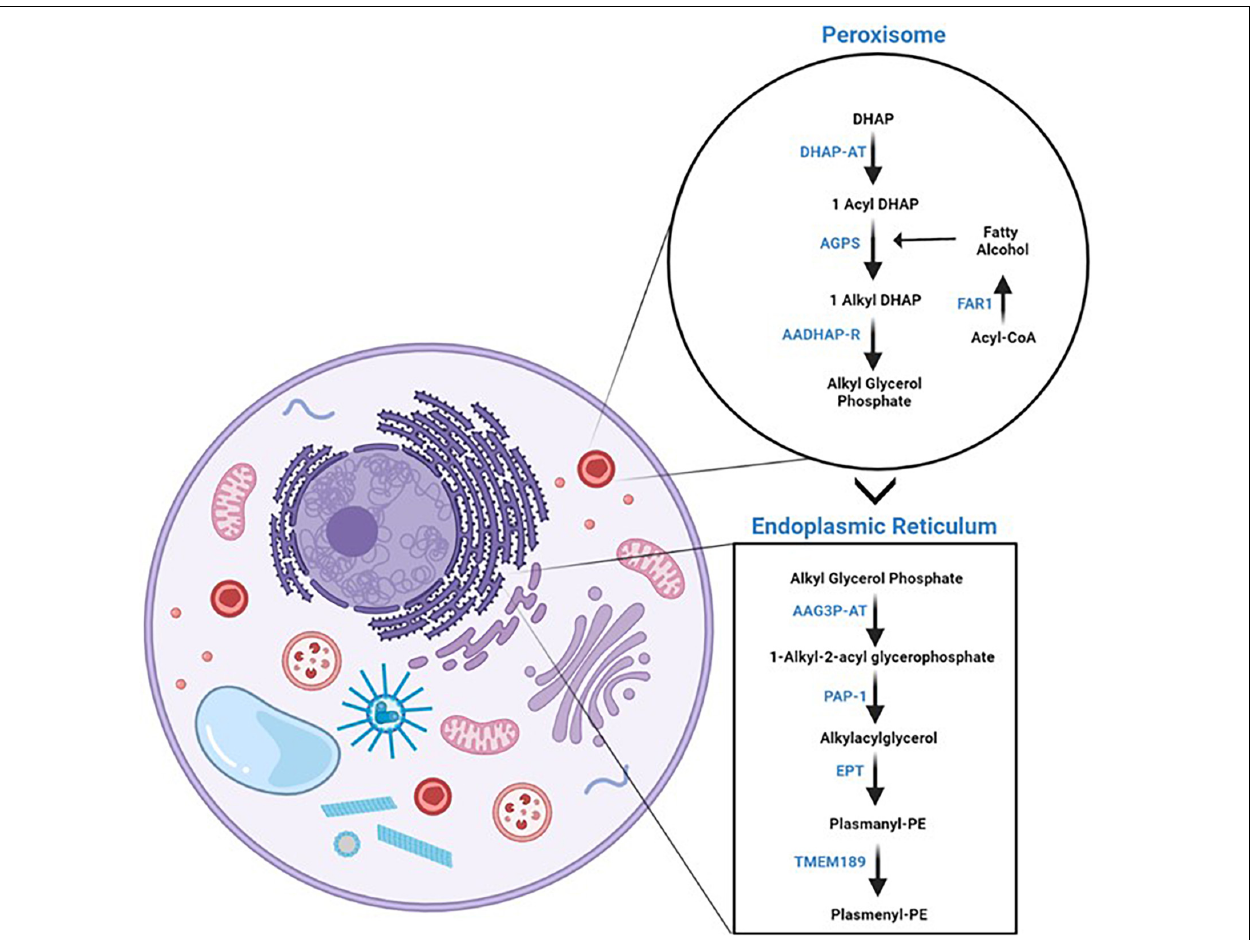
FIGURE 2 | Plasmalogen de novo biosynthesis. On the left panel, a cartoon of a cell with a focus on the organelles where plasmalogen de novo biosynthesis takes place, i.e. , peroxisomes and endoplasmic reticulum. On the right panel, the enzymatic reactions of plasmalogen de novo biosynthetic pathway are separated by the organelles where they take place. The reader is referred to the text for the names of the enzymes. Schematic representations were generated using Biorender (©BioRender -